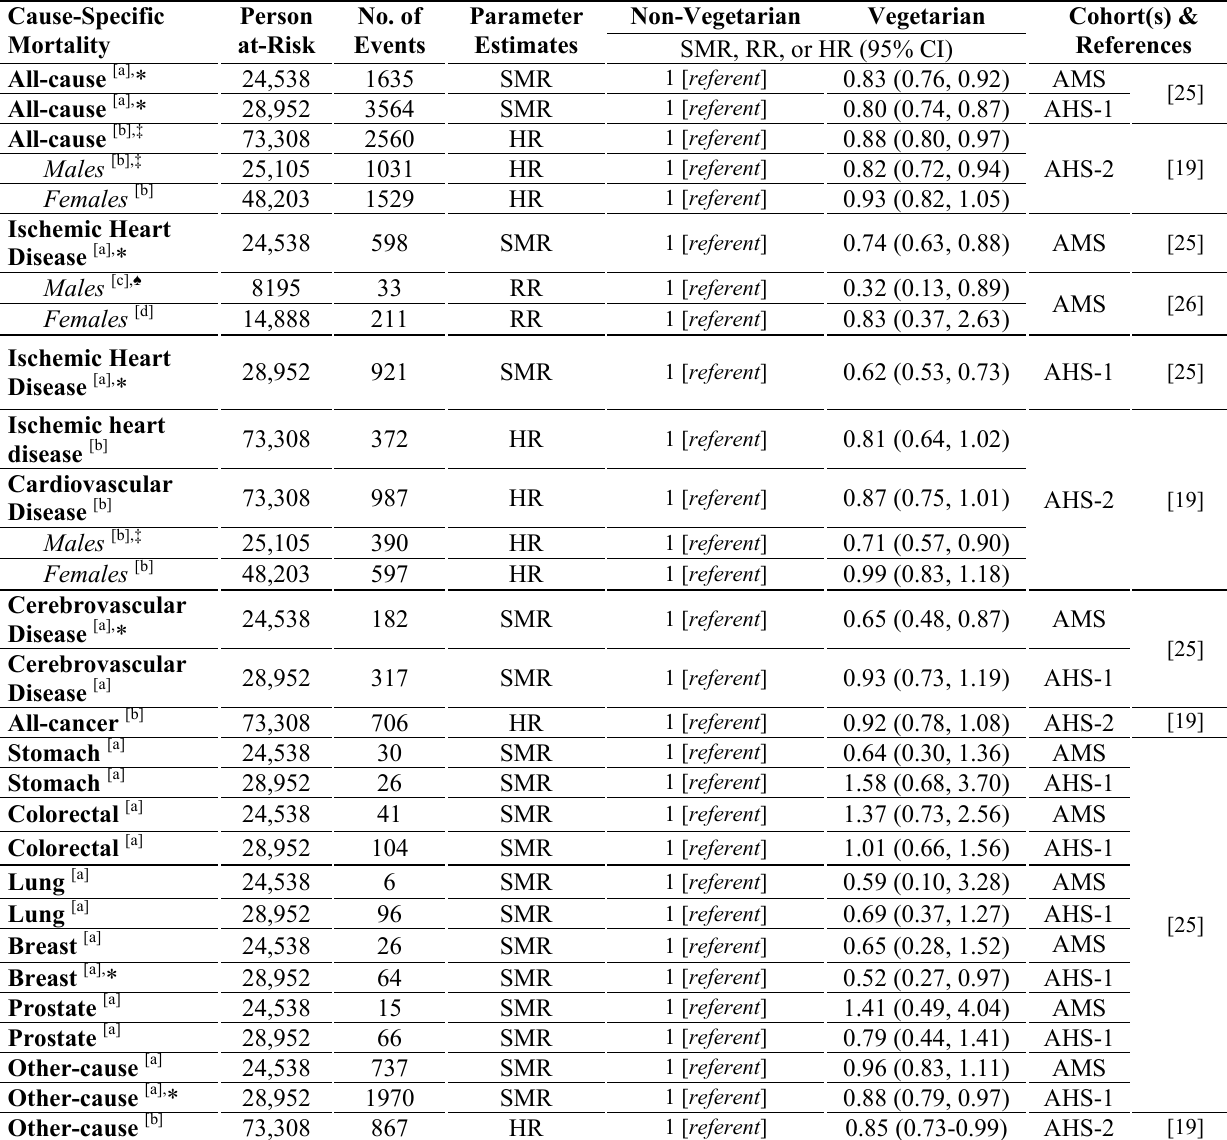
Table 5. All-cause and cause-specific mortality among vegetarian and non-vegetarian